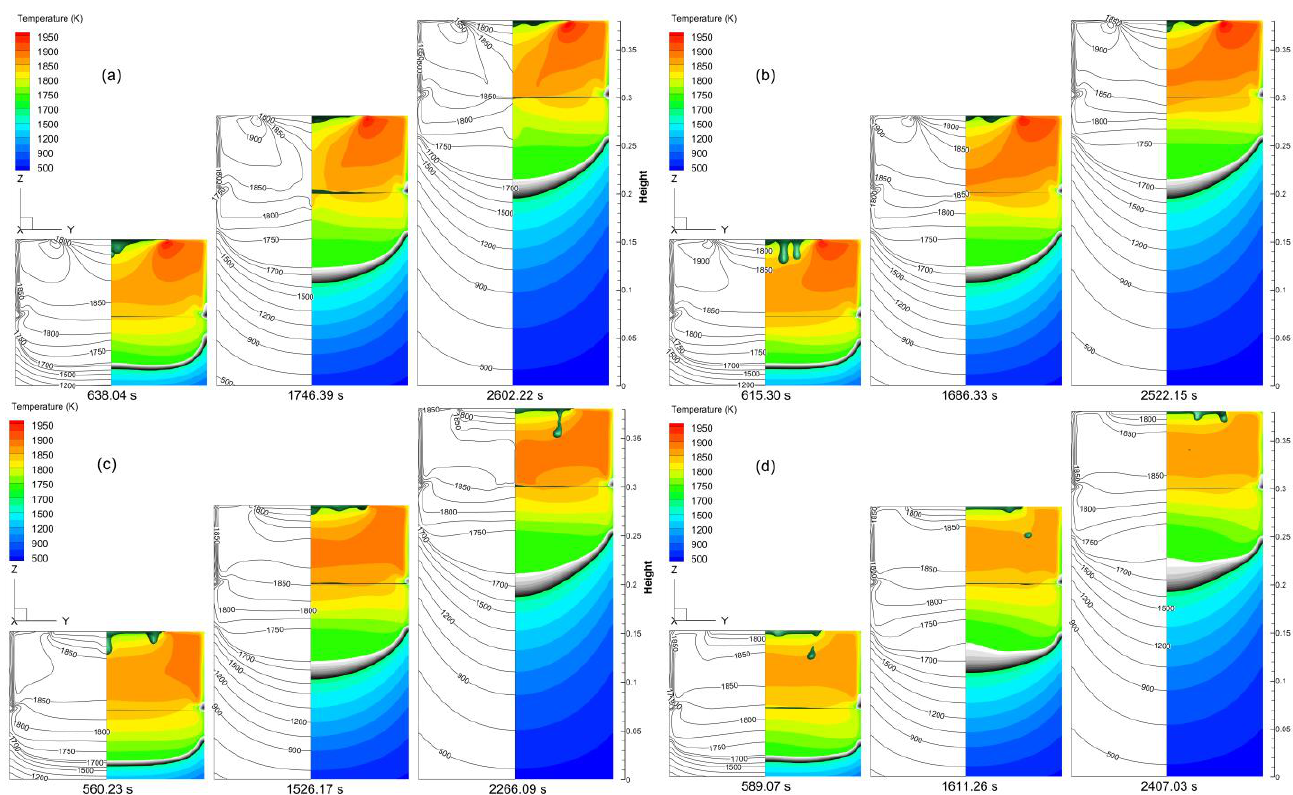
Figure 6. Predicted temperature distributions in the mold with the electrode rotating at different speeds: ( a ) 0; ( b ) 20 rpm; ( c ) 40 rpm; ( d ) 60 rpm.